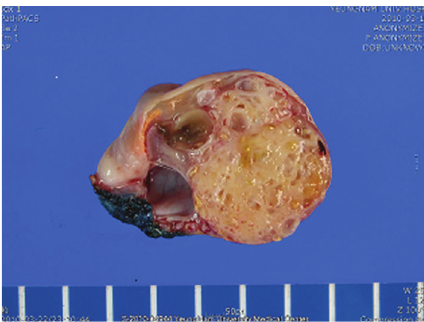
Figure 2: Photograph of the left ovarian tumour and the cut surface. Multiloculated cystic tumour with additional solid areas containing small